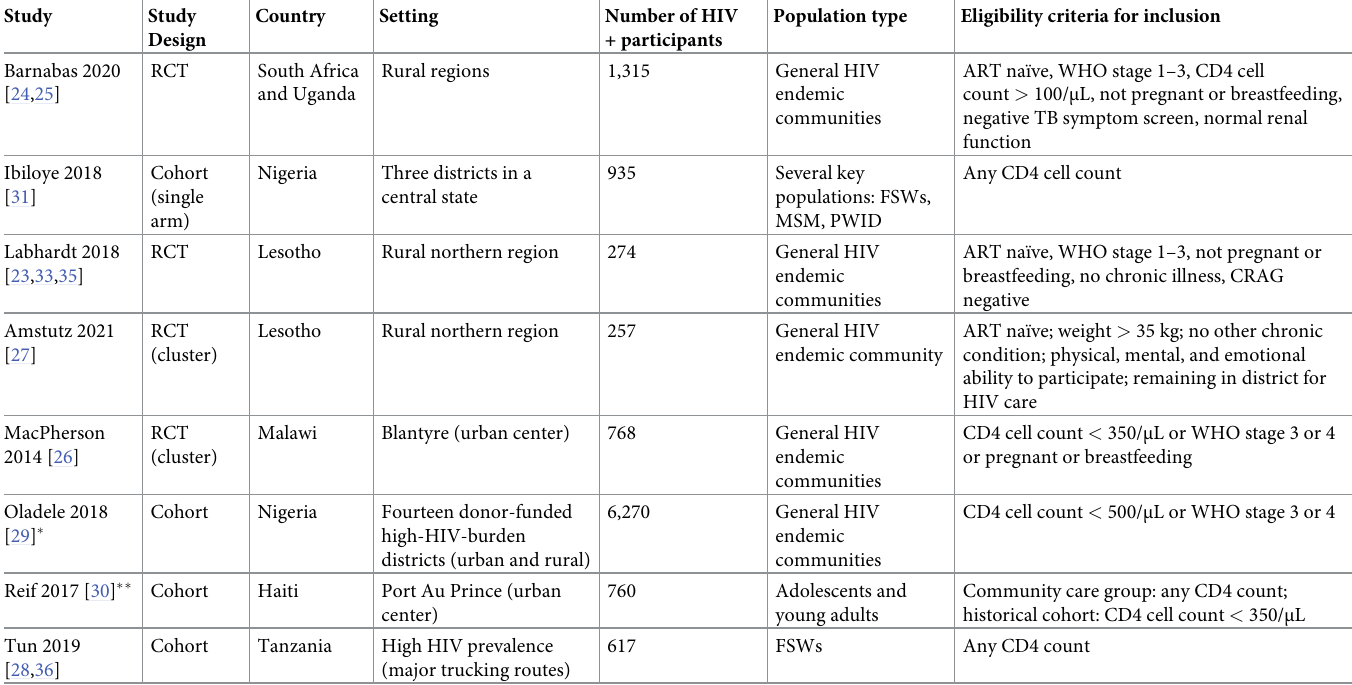
Table 1. General description of included